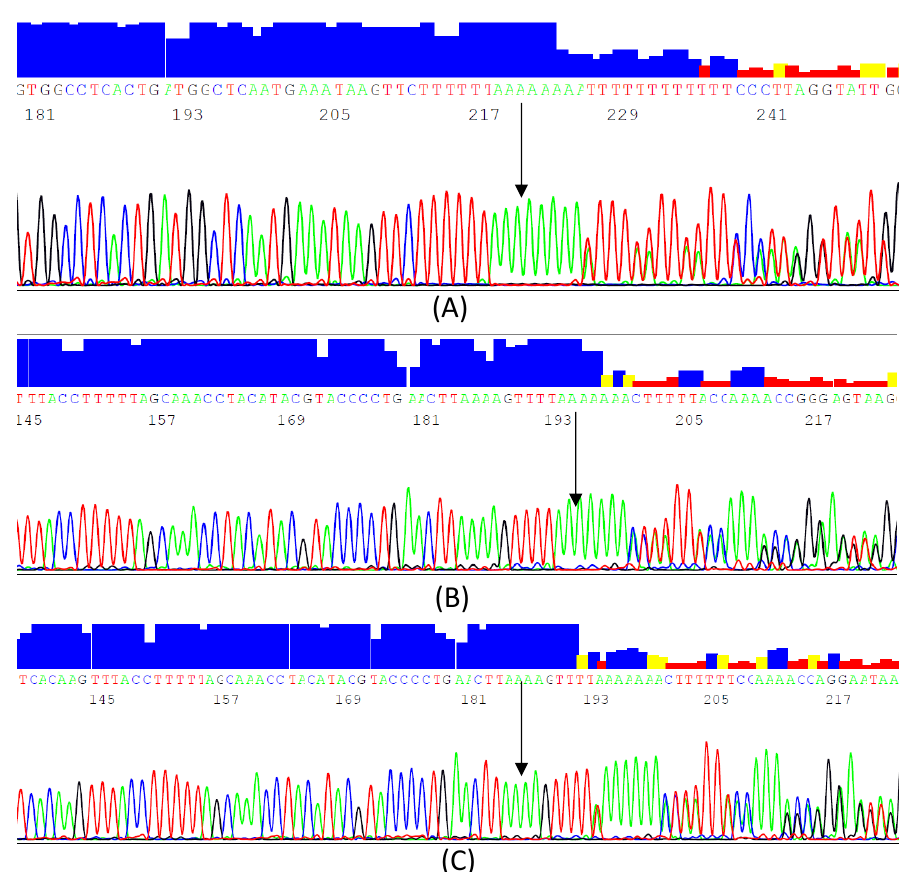
Figure 1. Sequencing electropherograms of the target regions (8:19956194-19956691 and 8:19958317- 19958887) in intron 6 at the lipoprotein lipase ( LPL ) gene locus showing the InDels identified. ( A ) (rs293) c.1019-685_1019-684insA (forward strand); ( B ) (rs274) c.1018+386_1018+387insA (reverse strand); ( C ) (rs274) c.1018+386_1018+387insA (reverse strand). The vertical bars represent the Quality values (QV) designated to each base of the sequencing reaction analyzed by the software. The blue bars represent values of ≥20 (very good data), while the yellow and red bars represent values <20 (poor data).